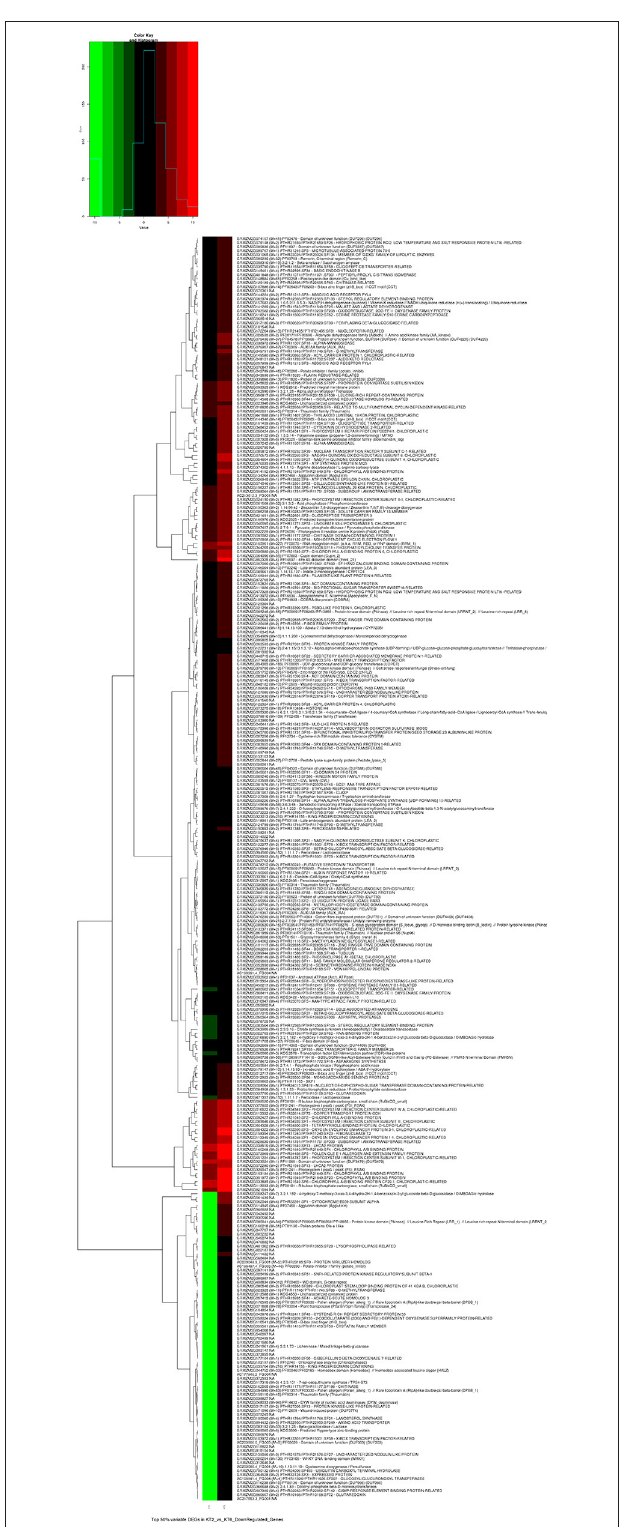
FIGURE 2 | KT2 vs. KT6 Heat map of top 50% highly variable downregulated